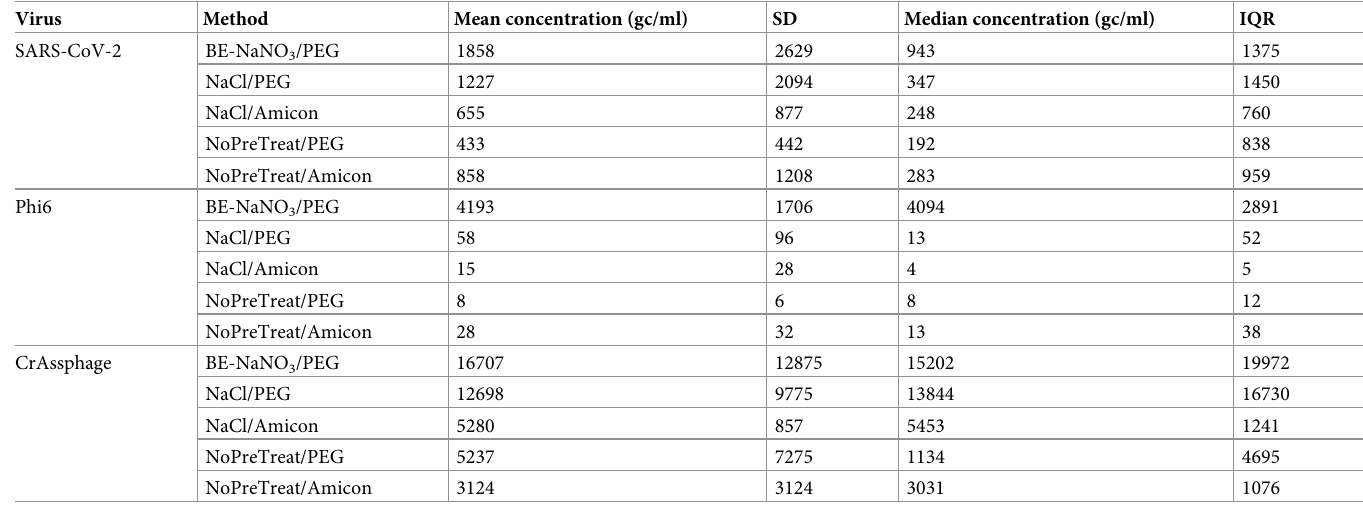
Table 4. Summary statistics for SARS-CoV-2 (N1 gene fragment) and phi6 showing higher viral recovery using BE-NaNO 3 pre-treatment. Virus